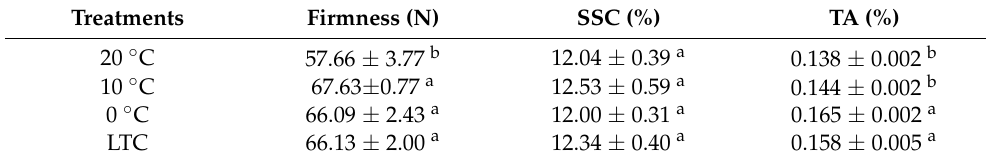
Table 4. Fruit quality of ‘Huangguan’ pear fruit with different treatments after 30 days of storage.